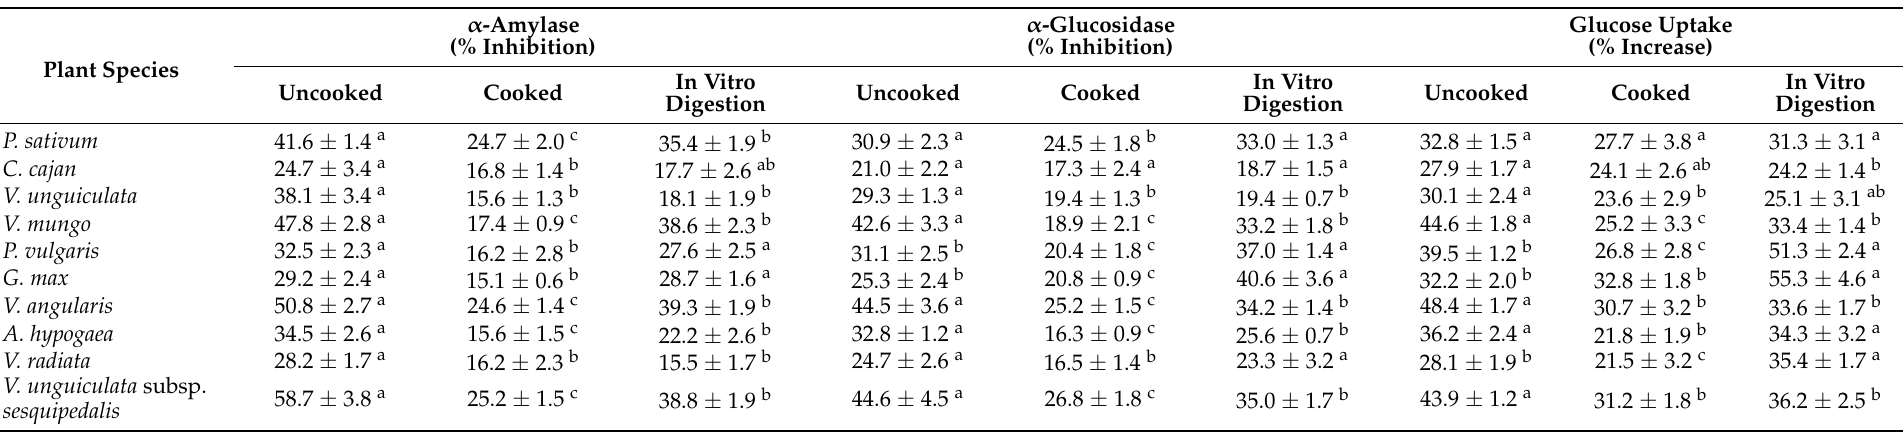
Different superscript letters indicate significant differences at p <